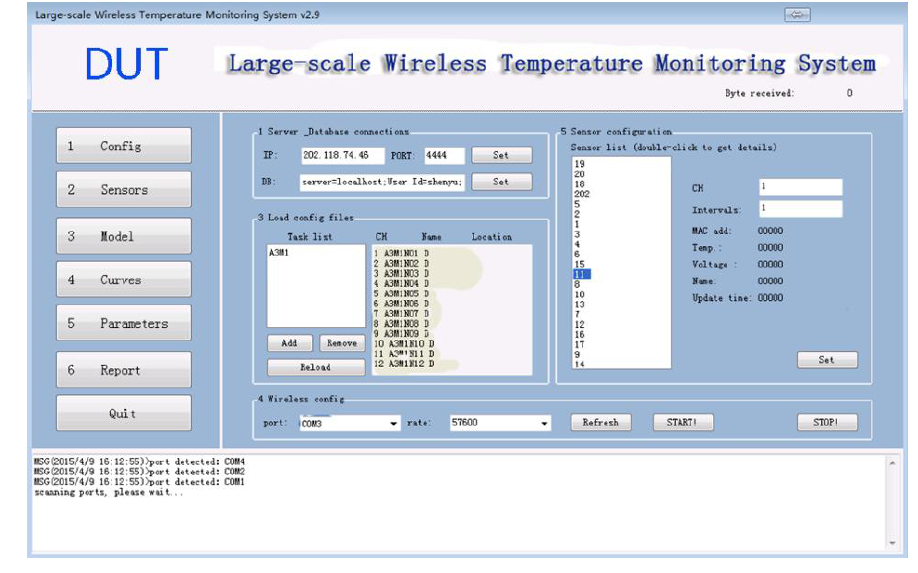
Figure 12. Configuration